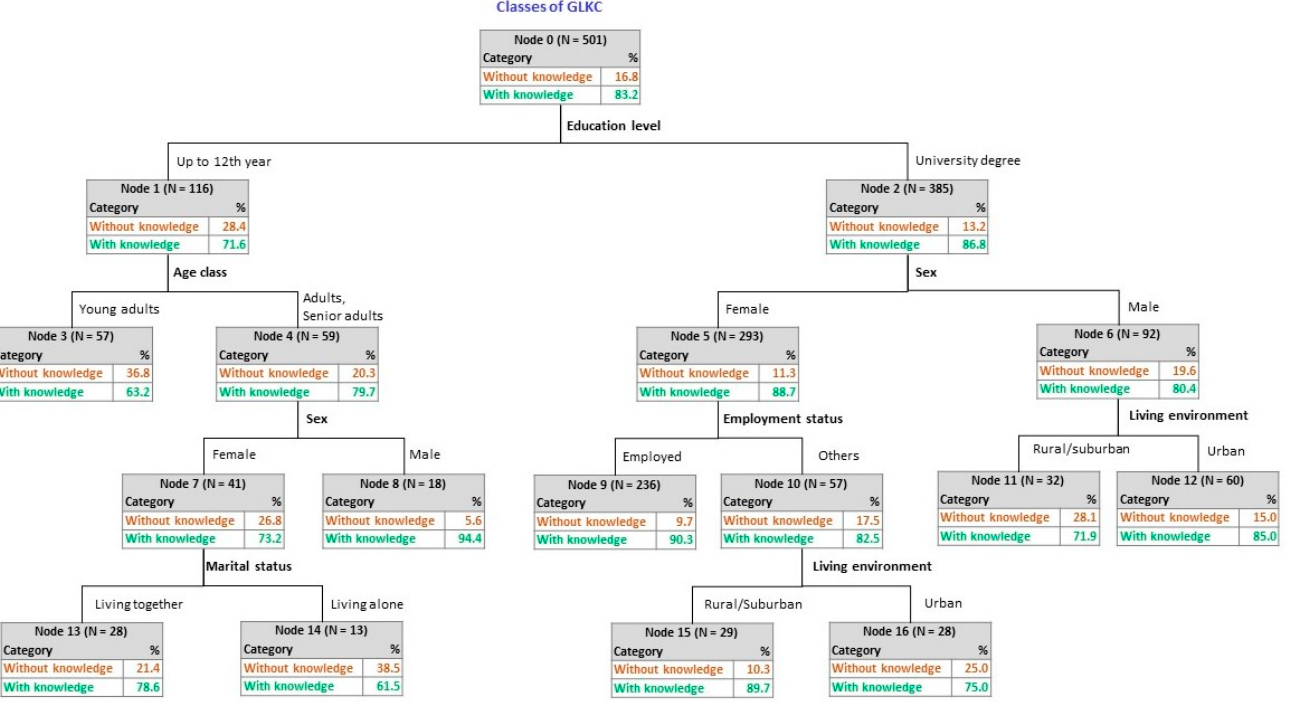
Figure 5. Tree classification for variable class of GLKC as a function of the sociodemographic variables.